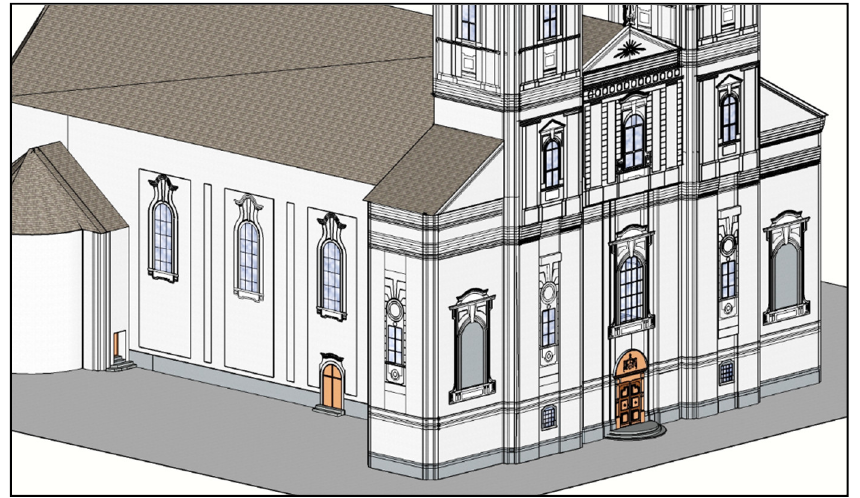
Figure 22. Remediation proposal with additional massive apses.